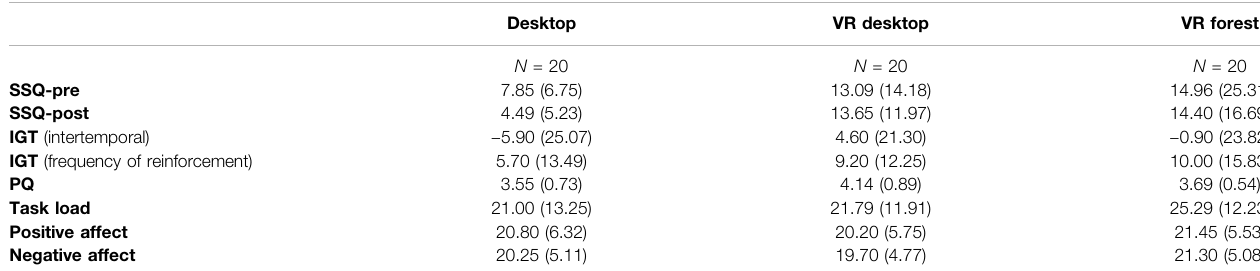
TABLE 4 | Descriptive statistics. Values are M ( SD